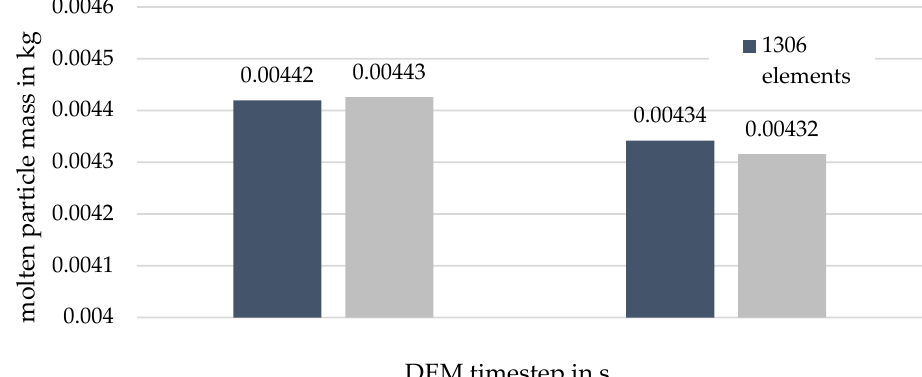
Figure A1. Molten particle mass depending on the number of calculation elements and the selected DEM time step. Figure A1 shows that the mesh and time step convergence was given for the coarser computational mesh with 7.232 elements at a DEM time step of 5 × 10 − 6 s. The CFD time step was chosen two orders of magnitude higher than the DEM time step and was thus 5 × 10 − 4 s . The average relative deviation due to the grid influence was less than 1%. Within different time steps, the average relative deviation was 2.17%. It was therefore sufficiently small to confirm the time-step